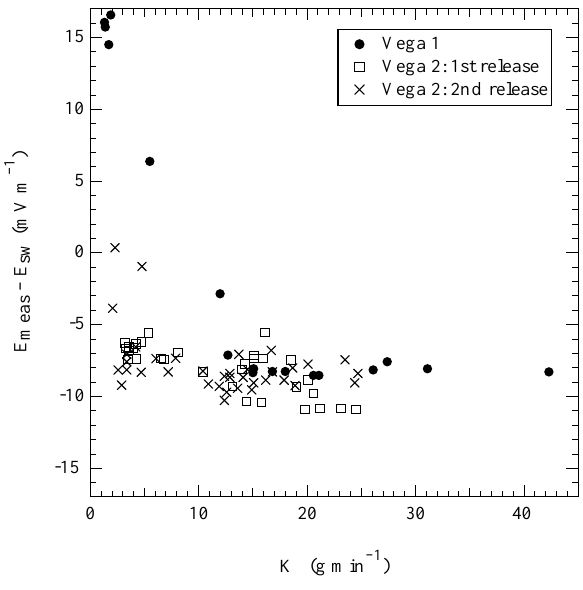
Fig. 8. Potential difference between the spacecraft and the probe plotted against the electron density; full circles are for Vega 1, open squares for Vega 2. The solid and dashed lines show empirical rela- tionships for two different boomlengths of the Polar spacecraft.